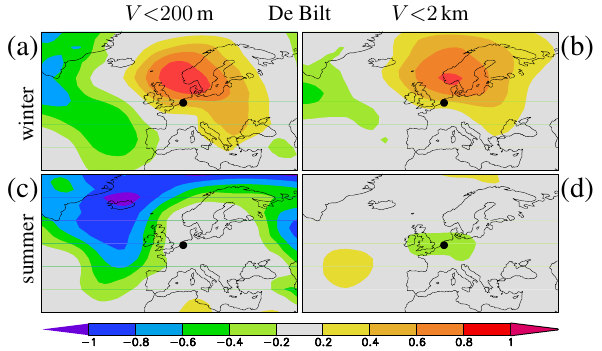
Fig. 9. As Fig. 8 but for Z¨urich Airport.